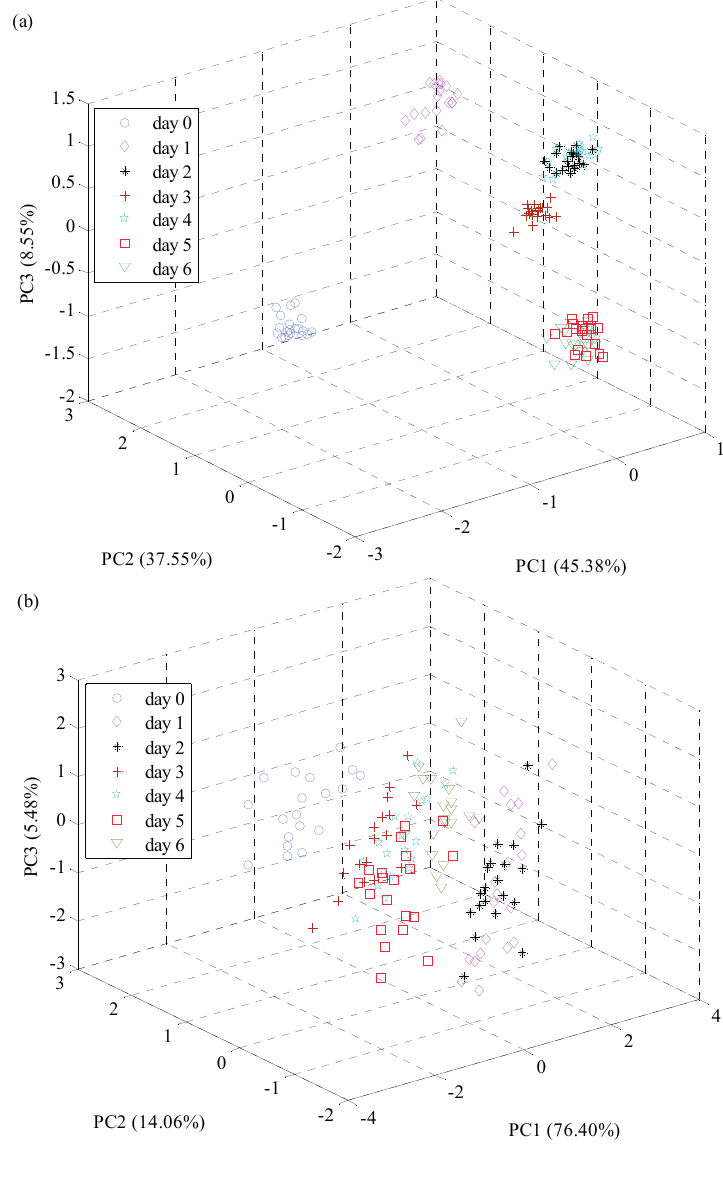
Figure 1. Score cluster plot with the top three principal components (PCs) from all samples. Score cluster obtained from ( a ) electronic nose data and ( b ) near infrared spectroscopy (NIRS)